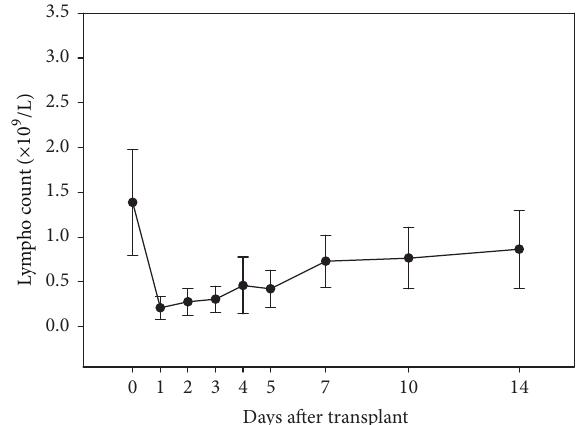
Figure 2: The average blood lymphocyte counts in retransplant patients before and after Thymoglobulin induction therapy. A satisfactory decline of peripheral blood lymphocyte count in the retransplant group was achieved with a 5-day period of Thymoglob- ulin induction therapy (total dosage: 125–150